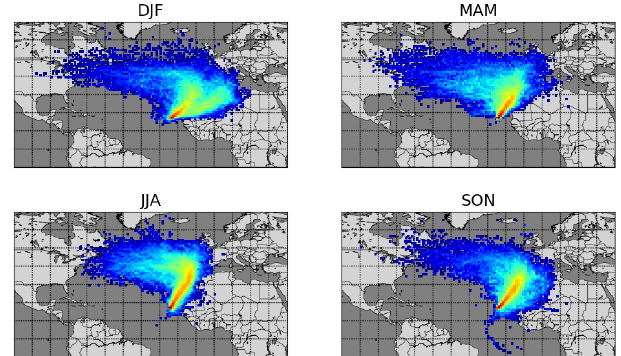
Figure 1. Seasonal average 10d back trajectories for the CVAO. Locations of released particles are plotted on a 1 ◦ × 1 ◦ grid, deter- mined using FLEXPART as described in Andersen et al.